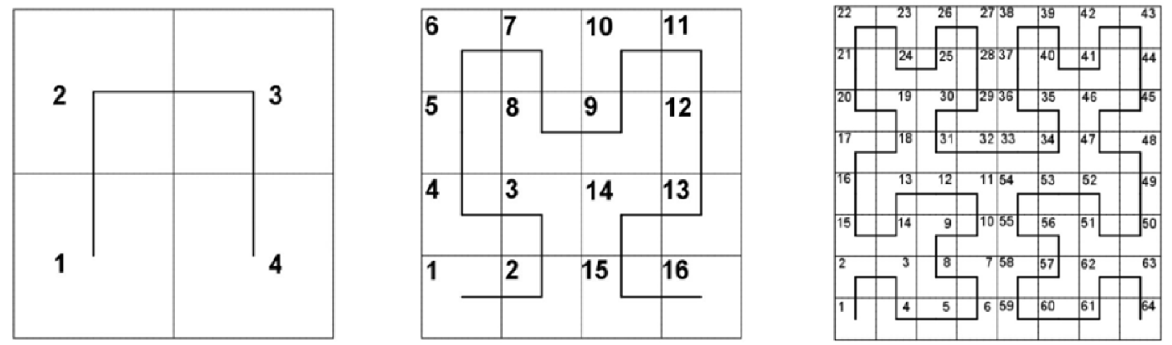
Figure 6: The first three stages in generating Hilbert’s curve